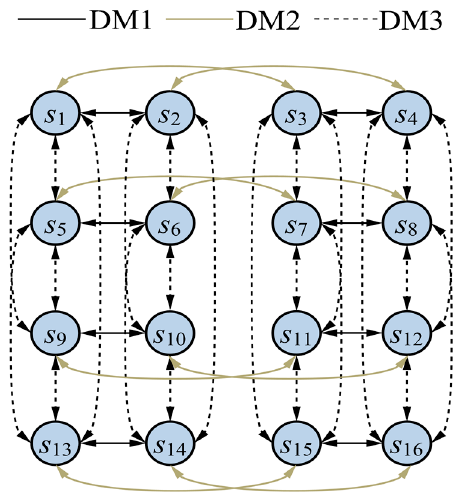
Figure 1. The integrated graph model.